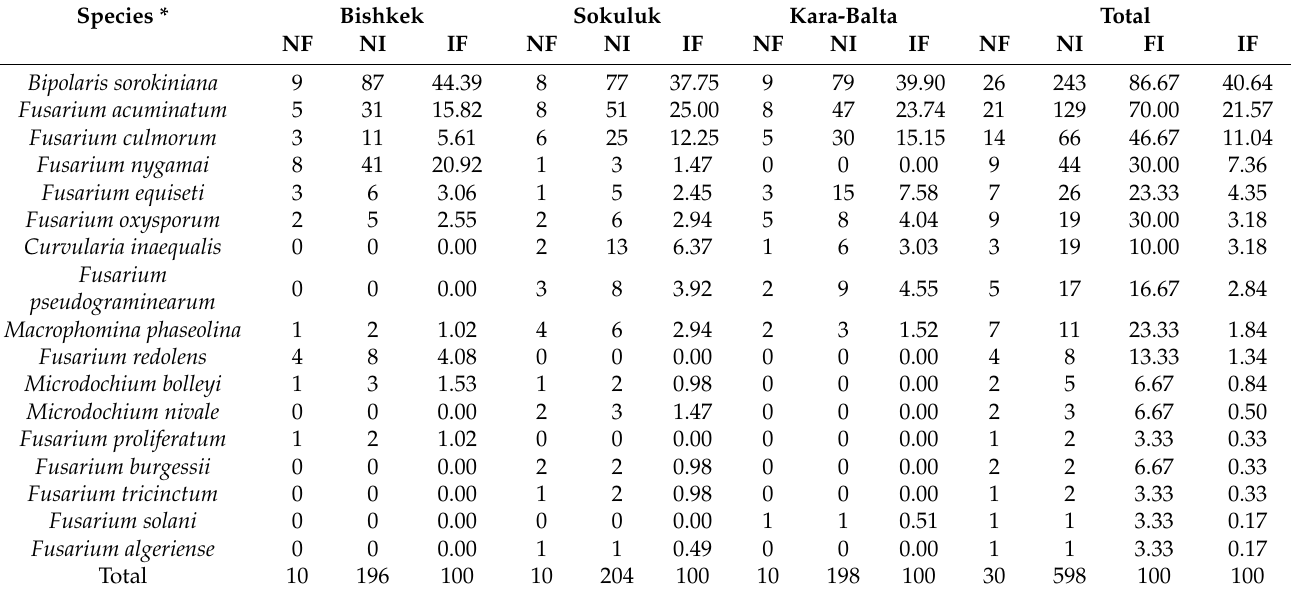
Table 1. The distribution of fungal species associated with wheat crown/root rot across three different wheat-growing regions in northern